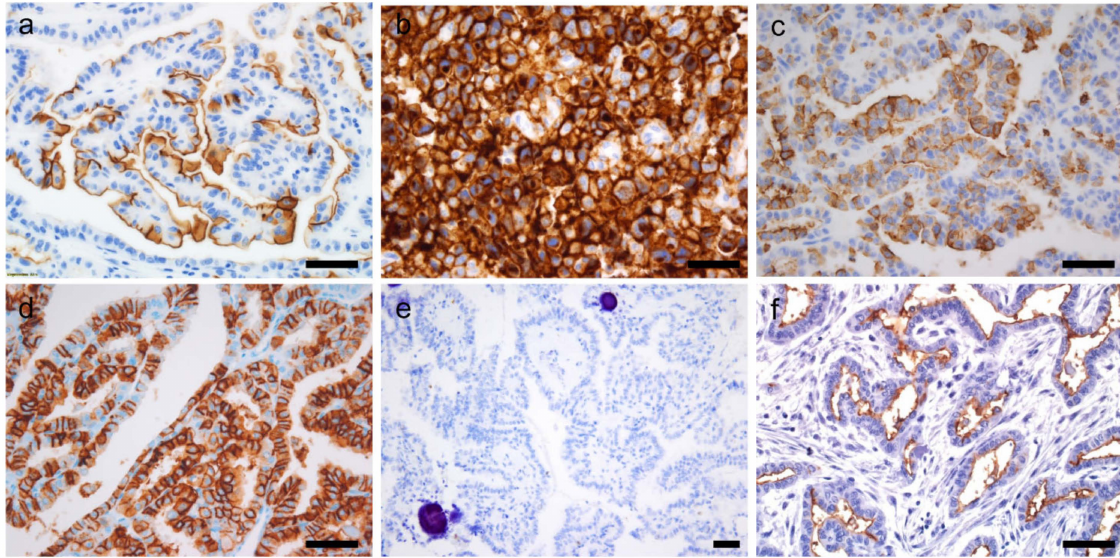
Figure 7. Immunohistochemical expression of CD markers by the thyroid cancer cells. CD10 expression in papillary thyroid carcinoma (PTC, a ) and anaplastic thyroid carcinoma ( b ), CD15 expression in PTC ( c ), CD20 expression in PTC ( d ), loss of CD56 expression in PTC ( e ), and CD73 expression in PTC ( f ). × 400 ( a – d , f ). × 200 ( e ). Scale bar = 50 µ